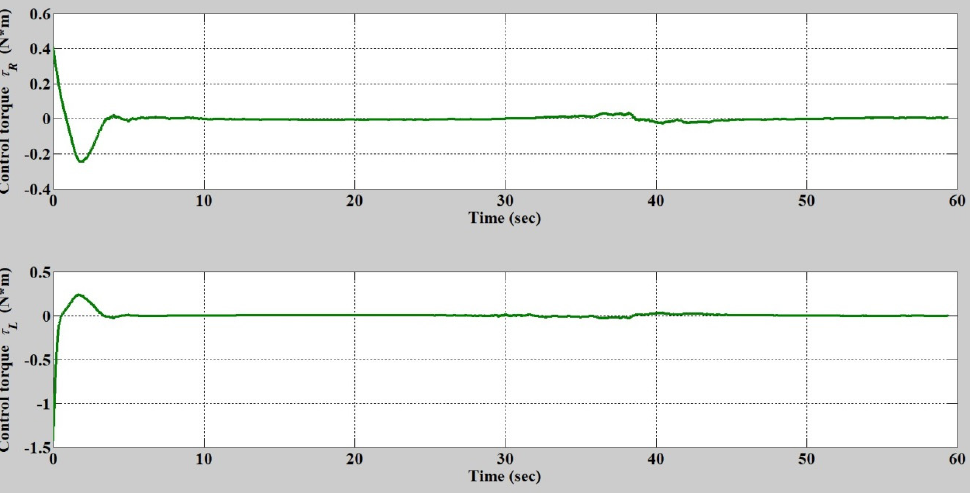
Figure 18. Results of S-type trajectory tracking torques concerning initial point ( x c = 0 m, y c = 1.9 m).